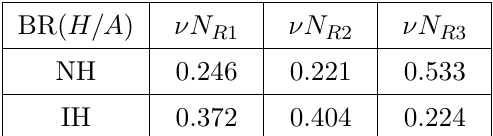
Table 2 . Branching ratios of the neutral scalars H=A into (cid:23)N Ri for NH and IH at m ! ij = 0 : 5 and upon summing over neutrinos (cid:23)